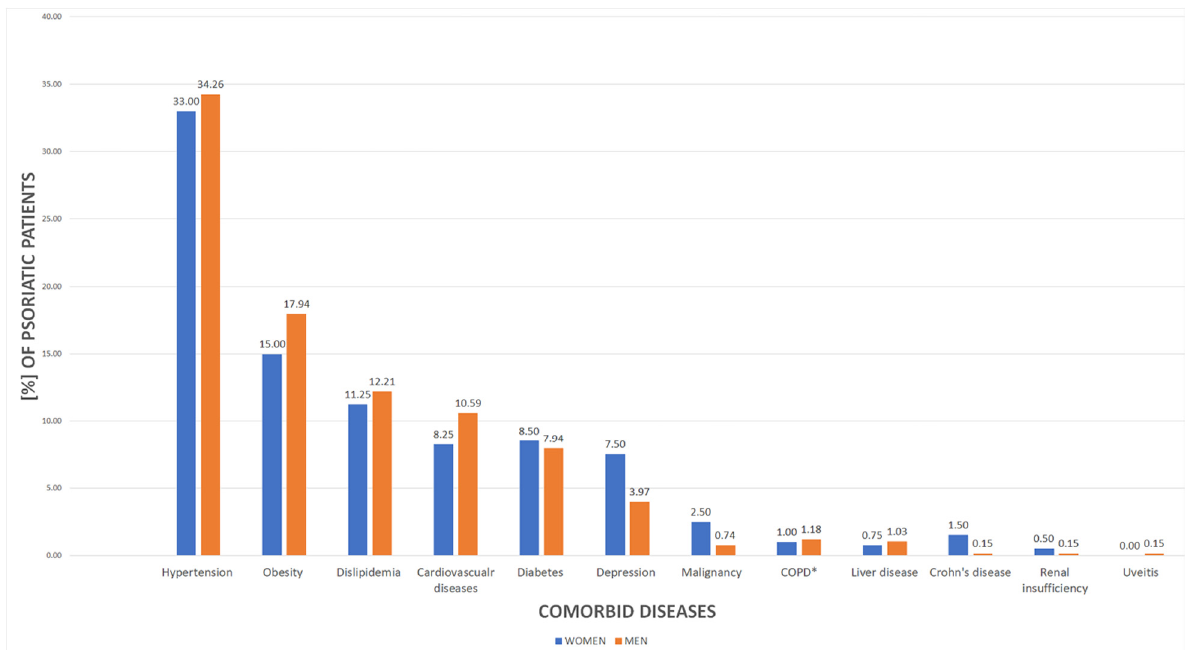
Figure 4. The prevalence of comorbid diseases among female and male psoriatic patients. * COPD, chronic obstructive pulmonary disease.